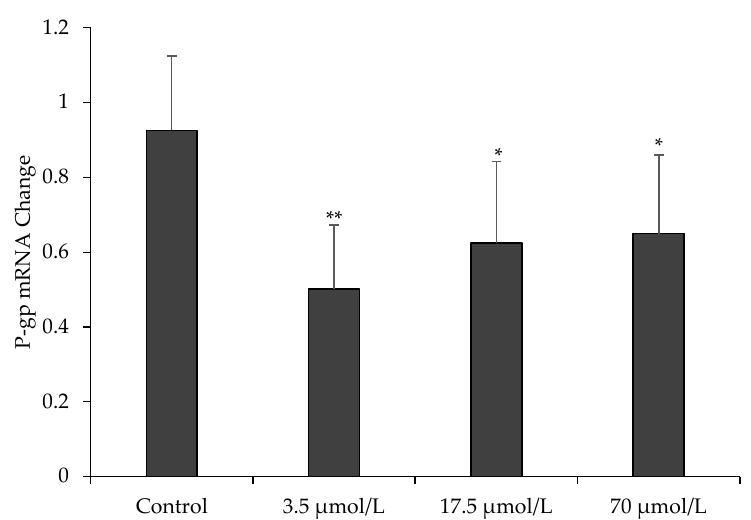
Figure 4. Effect of OPD on P-gp mRNA expression in MDCK-MDR1. Values are mean ± SD ( n = 3). Differs from control group: * p < 0.05 ** p < 0.01.